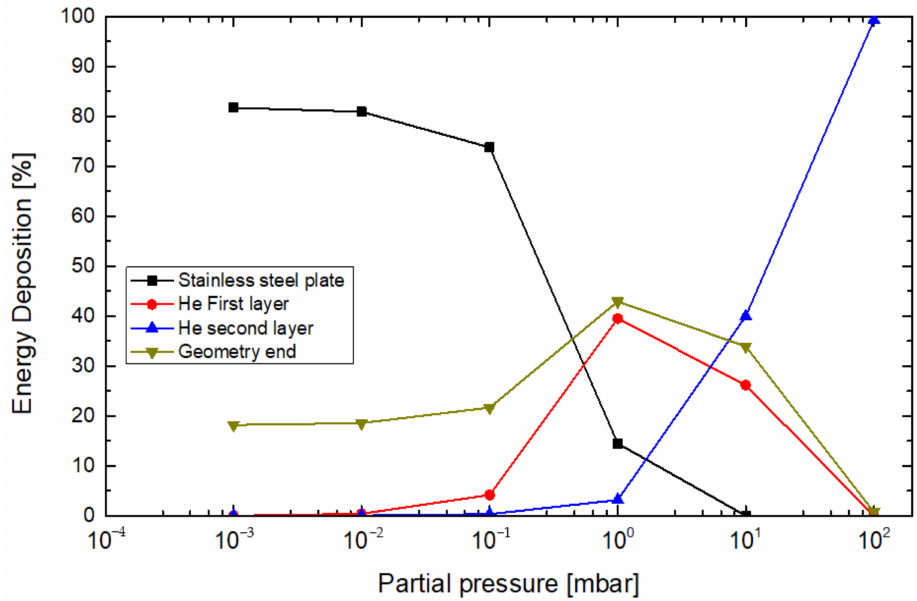
Figure 6. Results of MC simulations: the energy deposition as a function of gas pressure in each region: stainless steel plate, two zones of He layers, and outside of the geometry (backscattered).